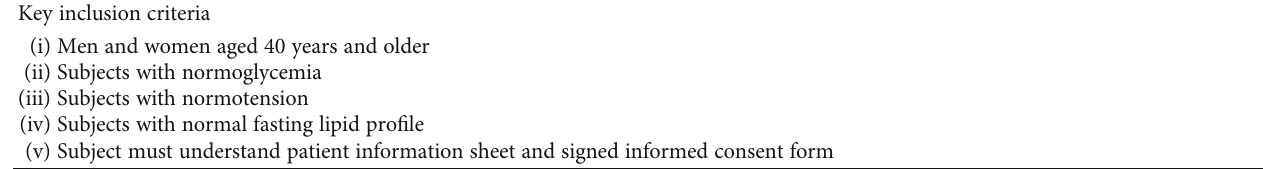
Table 1: Key inclusion and exclusion criteria for the enrolled